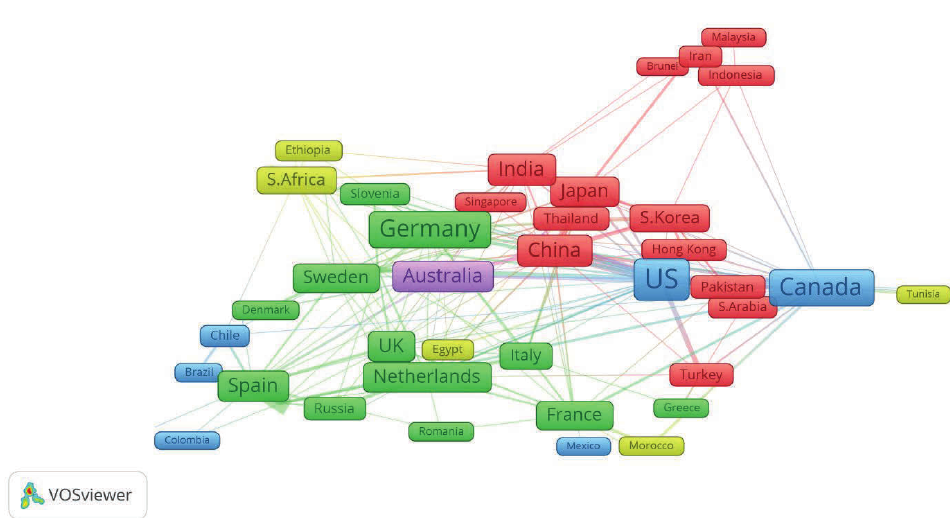
Fig. 4. Bibliometric map presented based on authors’ collaborations using mode network visualization VOSviewer